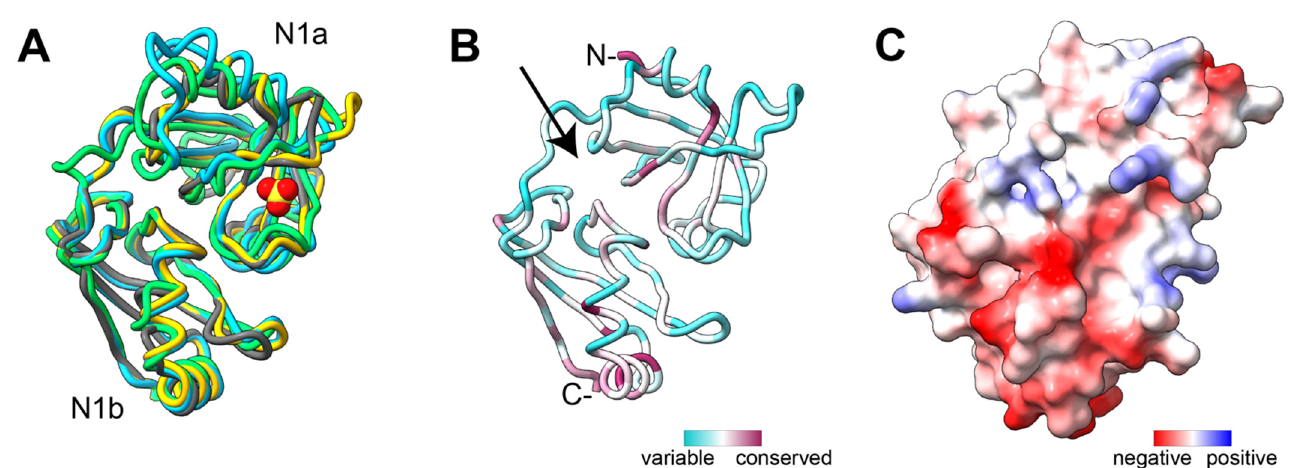
Figure 3. ( A ) The Alphafold2 predictions for Pex1 N1 domain structures in human (yellow), S. cerevisiae (green), and A. thaliana (blue) aligned to the X-ray crystal structure of murine PEX1 N1 (gray, PDB: 1WLF). The yellow/red ligand represents a sulfate from the PEX1 N1 crystal structure. ( B ) Sequence conservation mapped on the human PEX1 N1 domain. Cofactors such as Npl4 and FAF1 bind a similar cleft between subdomains (arrow) in Cdc48-N. ( C ) Coulombic potential mapped on the surface of human PEX1 N1 domain showing negative charge in the conserved region.